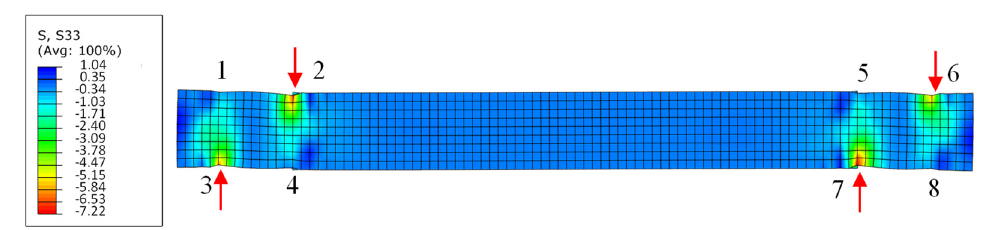
Figure 12. S33 of the beam when the displacement = +180 mm.